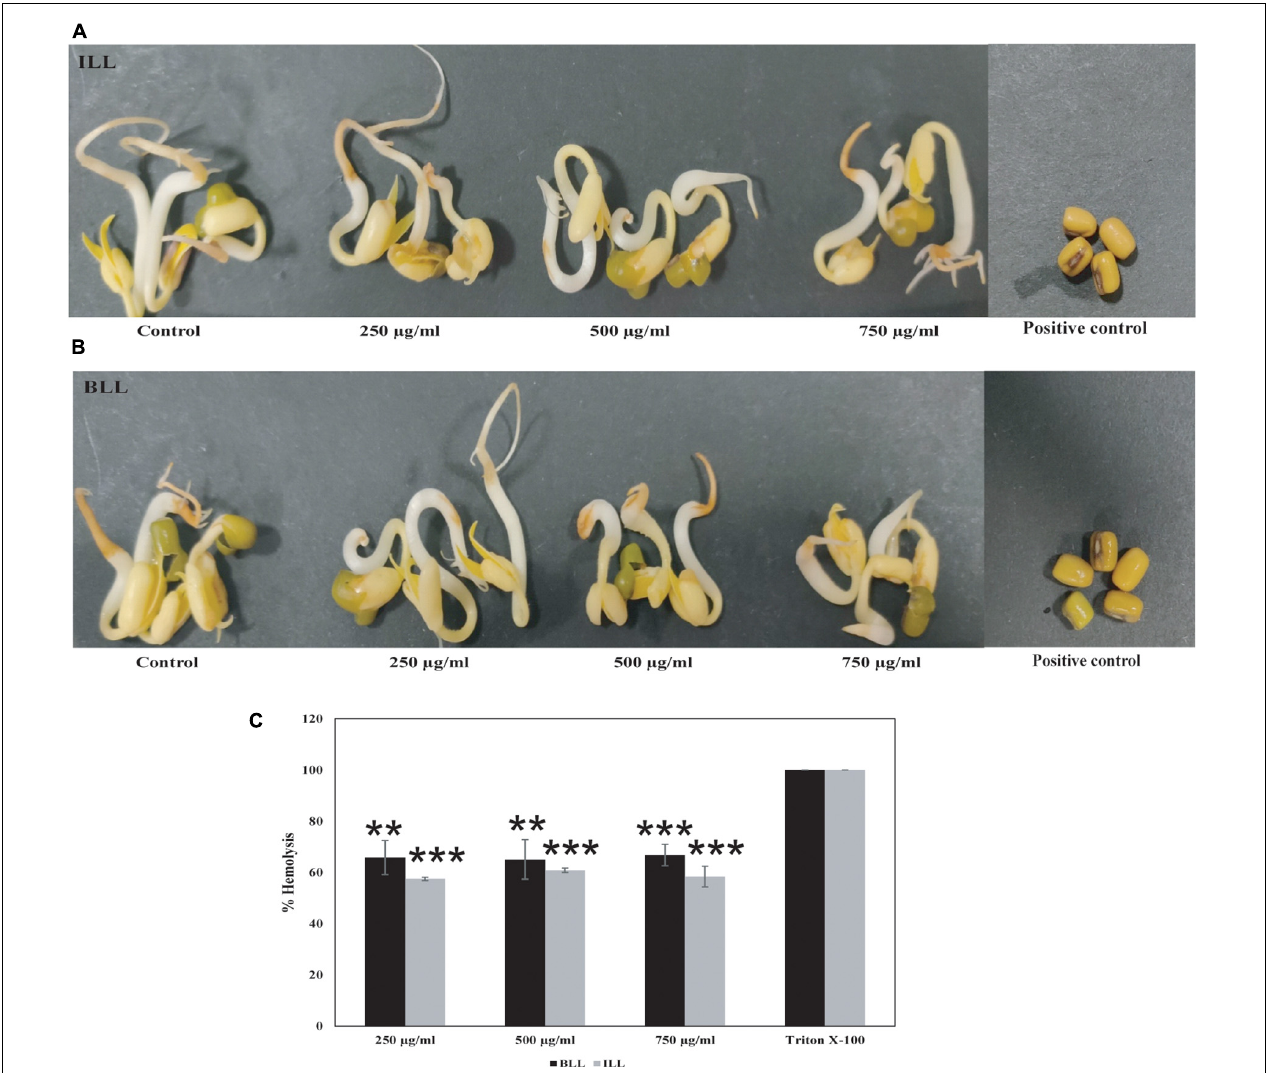
FIGURE 5 | Toxicity testing of antimicrobial lipopeptides. Seed germination-based phytotoxicity of (A) ILL (B) BLL using Vigna radiata . Water and 0.1% mercuric chloride were used as negative and positive control, respectively. (C) Hemolysis assay showing lysis of erythrocytes by both